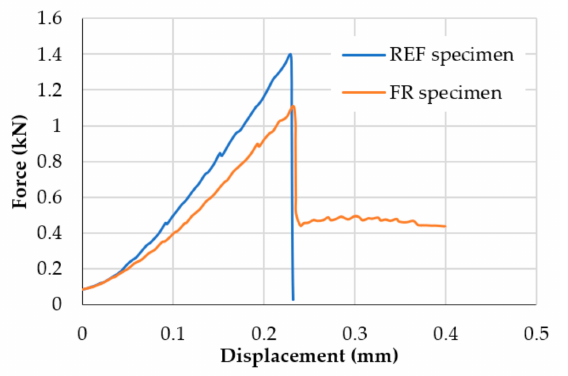
Figure 7. Comparison of experimental curves of bending test: specimen I2 (REF specimen) and specimen IFR2 (FR